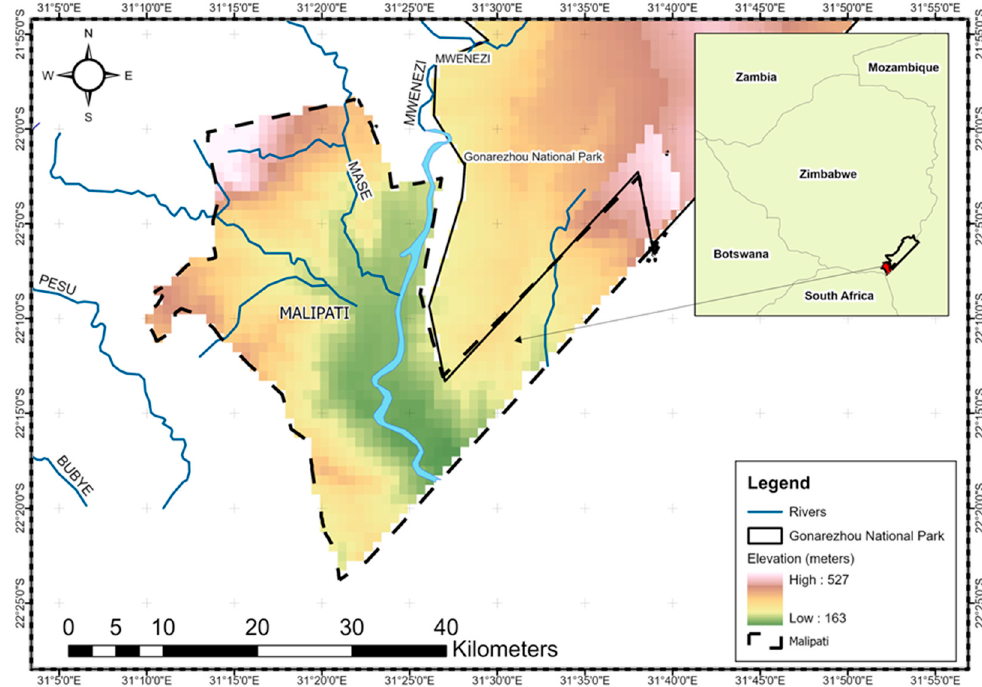
Figure 2. Location of Malipati, Ward 15 in Chiredzi District, Zimbabwe.